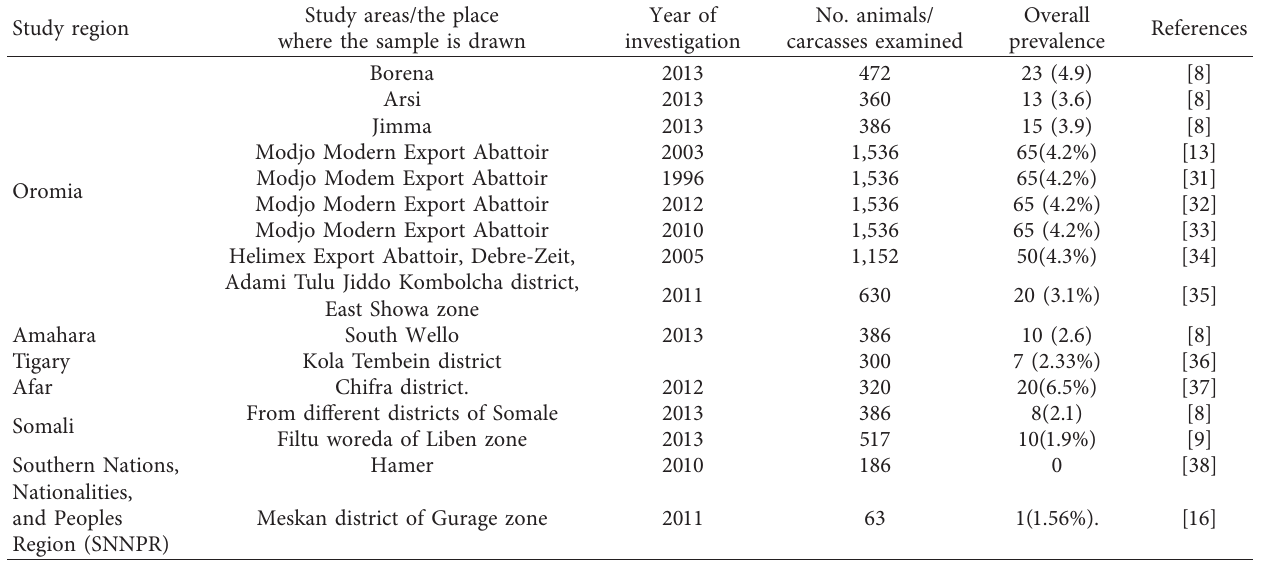
Table 1: Prevalence of some goat tuberculosis in different regions of Ethiopia.